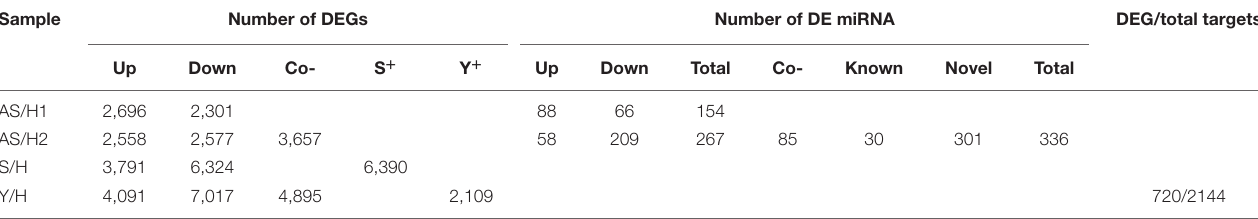
TABLE 1 | Number of regulated genes and miRNAs in periwinkle infected with “ Candidatus Liberibacter asiaticus.” Sample Number of DE miRNA